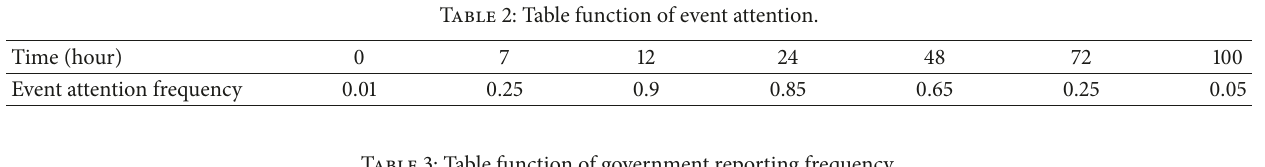
Table 3: Table function of government reporting